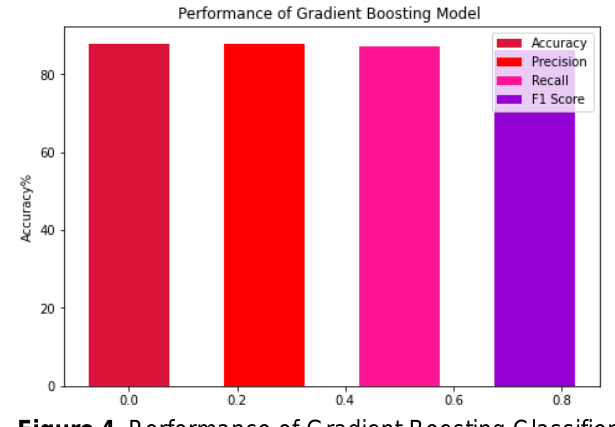
Figure 4. Performance of Gradient Boosting Classifier